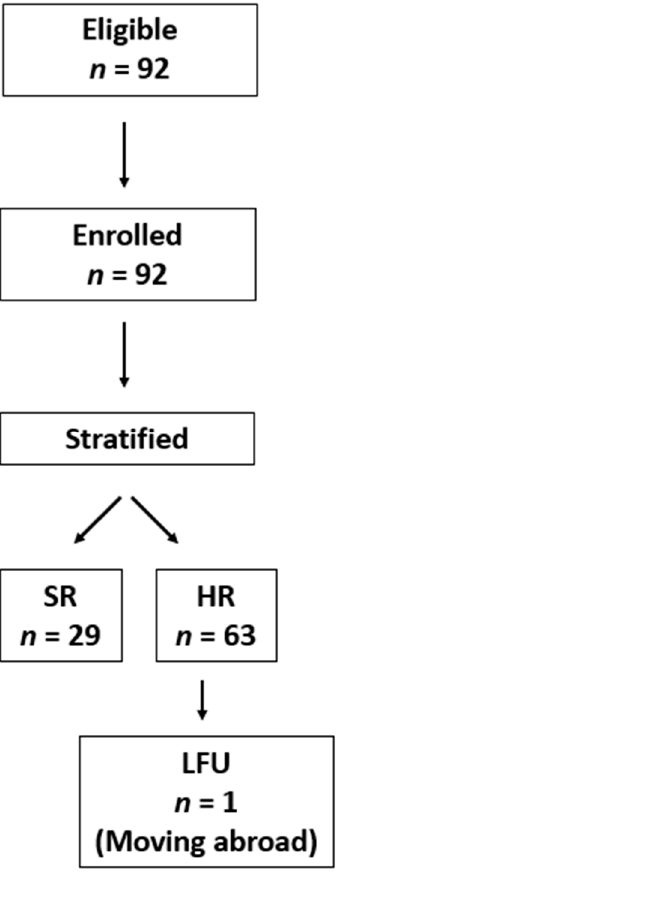
Figure 1. Flow of participants from enrollment to follow-up and analysis. Patients of the HPOG were not randomized and were treated according to the standard treatment arms of the protocol, i.e., “AIE” block for induction 1, “AI” block for consolidation, and 18 Gy cranial irradiation as part of CNS prophylaxis were applied. Abbreviations: HR: high risk, LFU: lost to follow-up, SR: standard